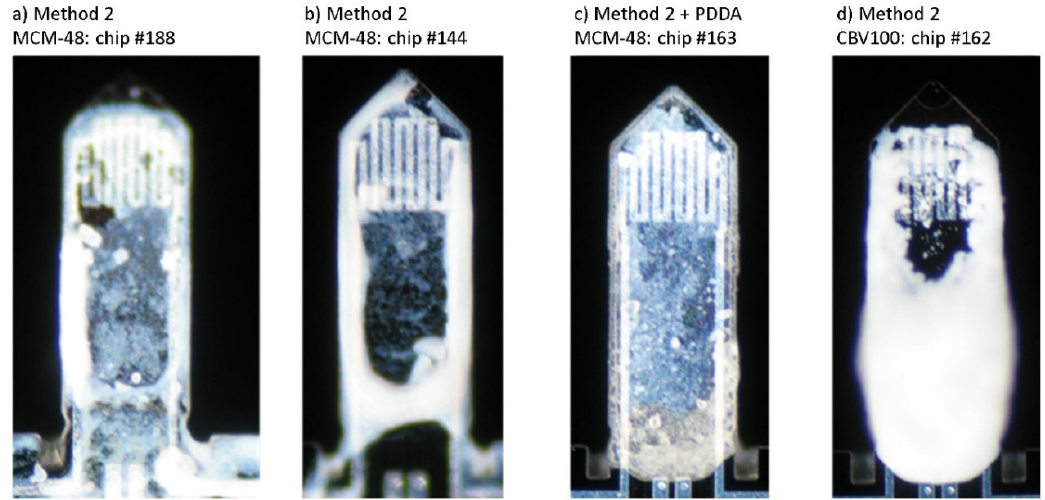
Figure 9. Optical microscope images of cantilevers coated by spotting of a suspension of nanoparticles directly onto the cantilever top surface according to method 2. ( a ) MCM-48 on chip #188. ( b ) MCM-48 on chip #144. ( c ) PDDA and MCM-48 on chip #163. ( d ) CBV100 on chip #162.